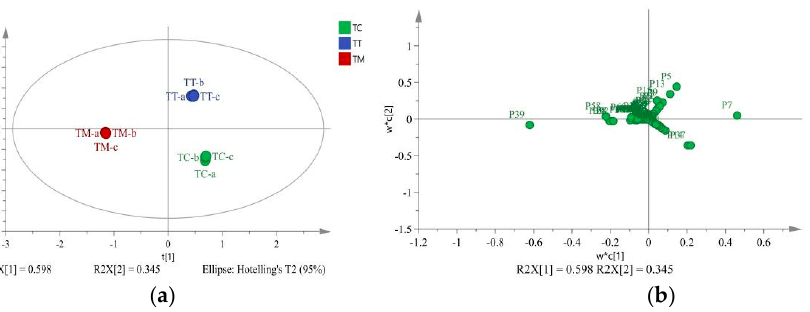
Figure 3. PLS-DA model for aroma components at different stages of the three species. ( a ) Score scatter plot; ( b ) Loading scatter